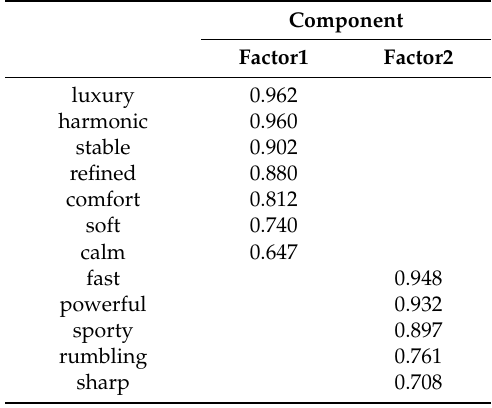
Table 2. Descriptive statistics for affective dimensions in samples. 213